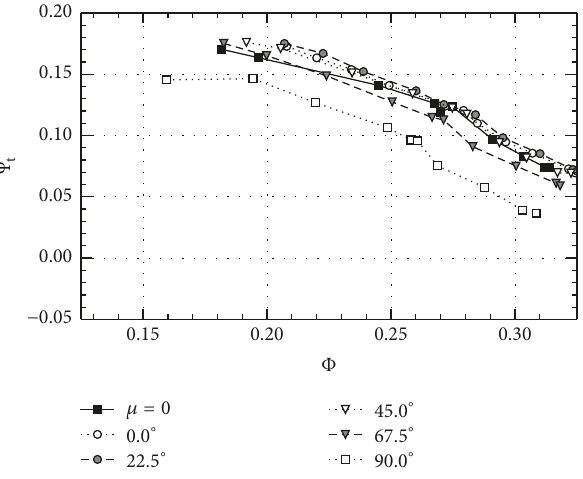
Figure 8: Fan A FD-RI-noGG total fan pressure at 𝜇 = 0.25 and different 𝛾 .